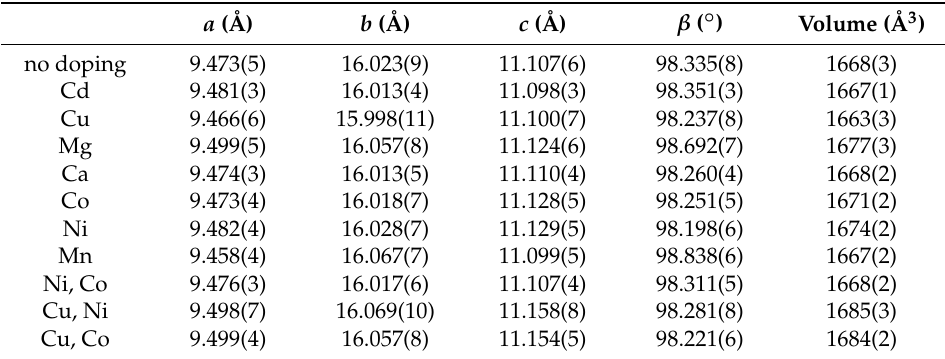
Table 3. Crystallographic low temperature data for doped MOFs {M-Zn-BTC}{Me 2 NH 2+